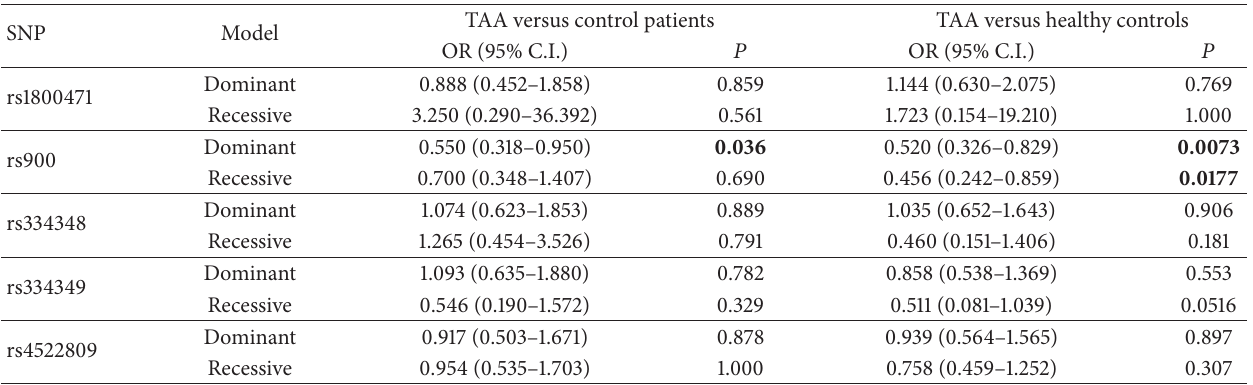
Table 5: Multiple logistic regression analyses of dominant (major allele homozygotes versus heterozygotes plus minor allele homozygotes) and recessive (major allele homozygotes plus heterozygotes versus minor allele homozygotes) models applied to TAA patient group compared with control